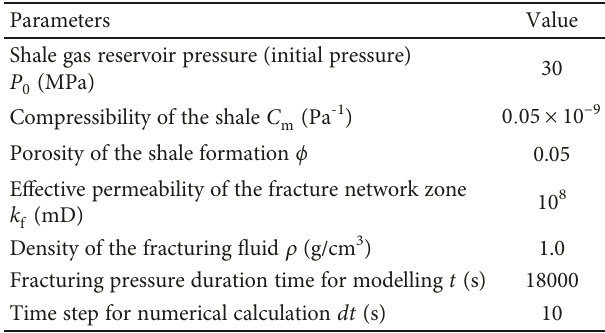
Table 2: Parameters used in the numerical